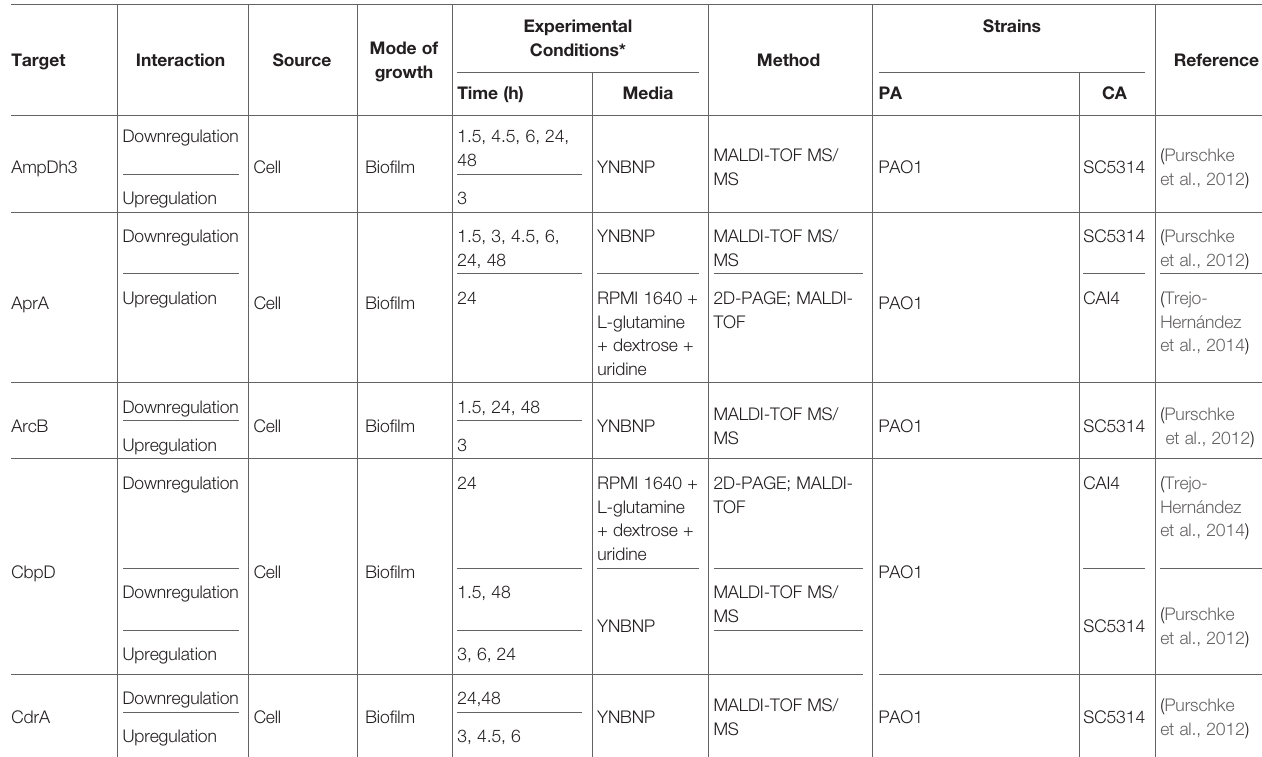
TABLE 3 | Contrasting C. albicans > P. aeruginosa